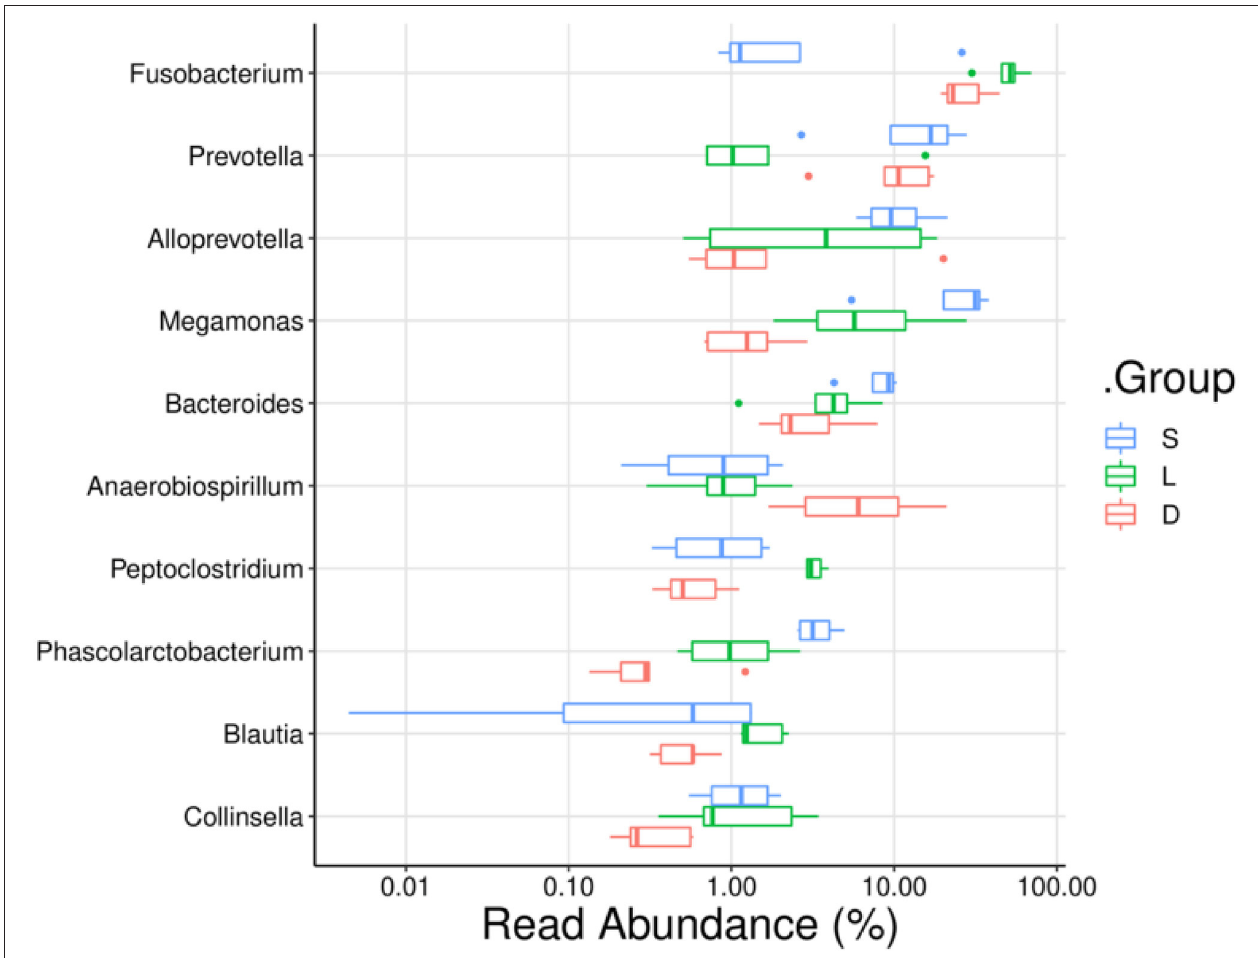
FIGURE 6 | Comparisons of the relative abundance of dog gut microbiota at the genus level. The ordinate indicated the bacterial name at genus levels, and the abscissa indicates the abundance percentage values of the samples.